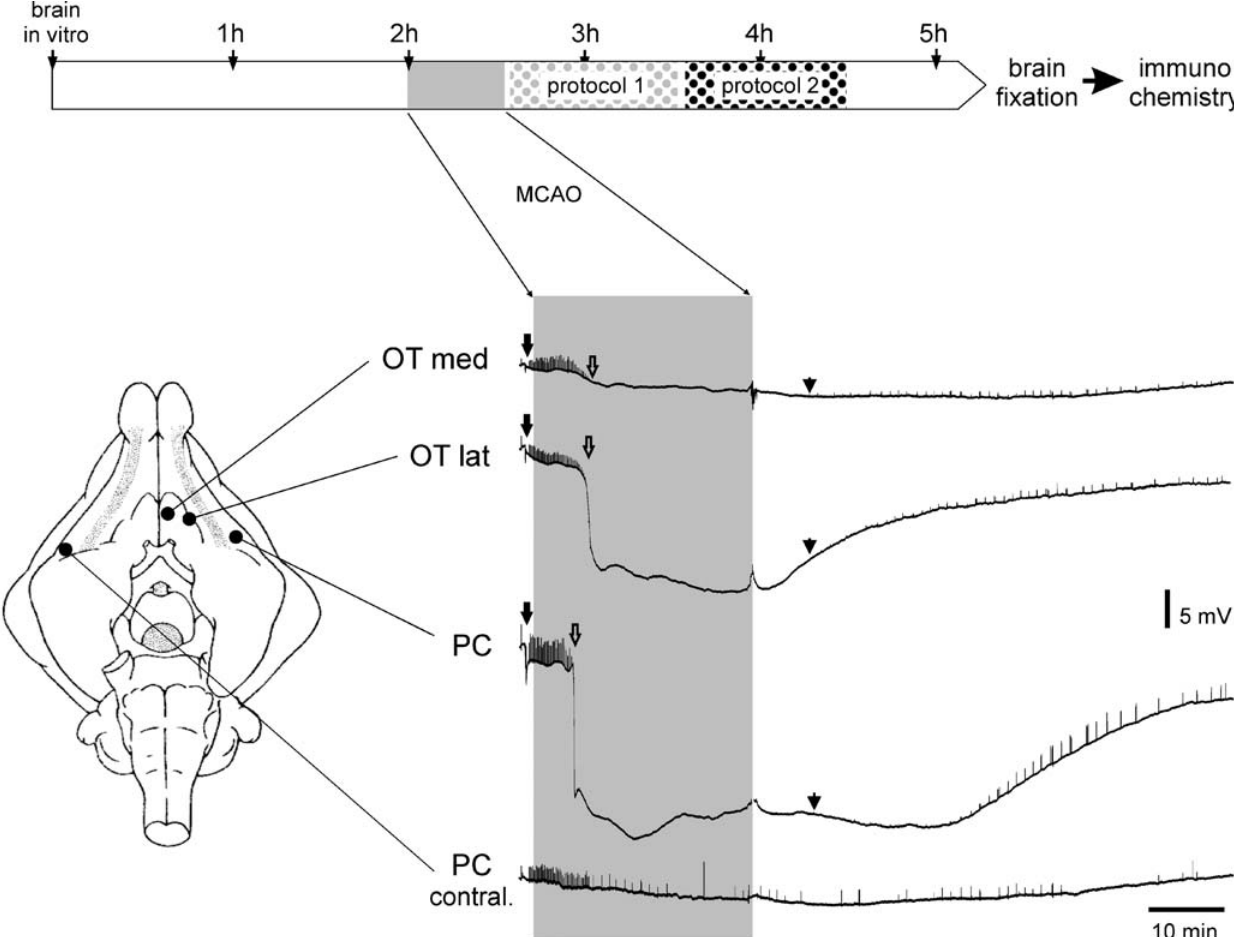
Figure 1. Experimental protocols. Ischemia was induced for 30 minutes, 2 hours after the in vitro placement of the isolated brain. NC were perfused for 1 h immediately either after the reopening of the vessel or 1 our later (protocol 2). The perfusion was followed by a wash-out period with a solution without NCs. At 5 hours in vitro the brains were fixed for immunohistochemistry. The bottom of the panel shows an example of simultaneous DC recordings from 4 different sites in an isolated guinea pig brain. Hypoxic depressions (HD) were recorded in the electrodes located in the regions vascularized by the occluded MCA. Potentials evoked by LOT stimulation before and during the first part of ischemia (arrowhead) disappeared when HD occurred, and recovered during MCA reperfusion. Evoked potentials in the hemisphere contralateral to MCA occlusion were not altered.